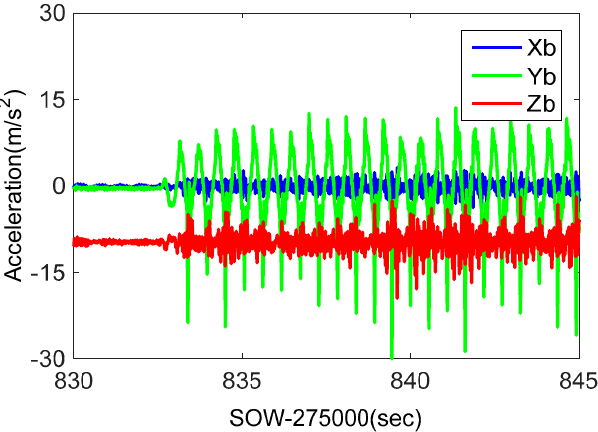
Figure 16. Recorded accelerometer raw data in shake table tests.